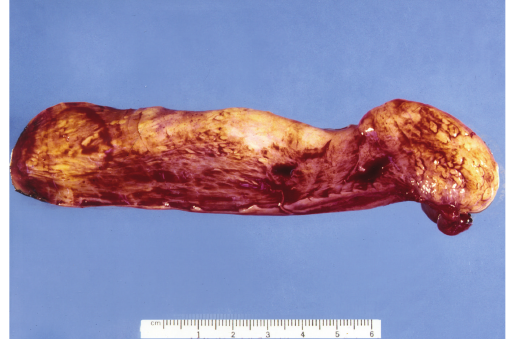
Figure 2: Resected fibrolipoma specimen measuring 15 × 2.6 cm and weighing 53 g. The inferior apex of the polyp (at right) shows ulceration due to reflux of gastric content.